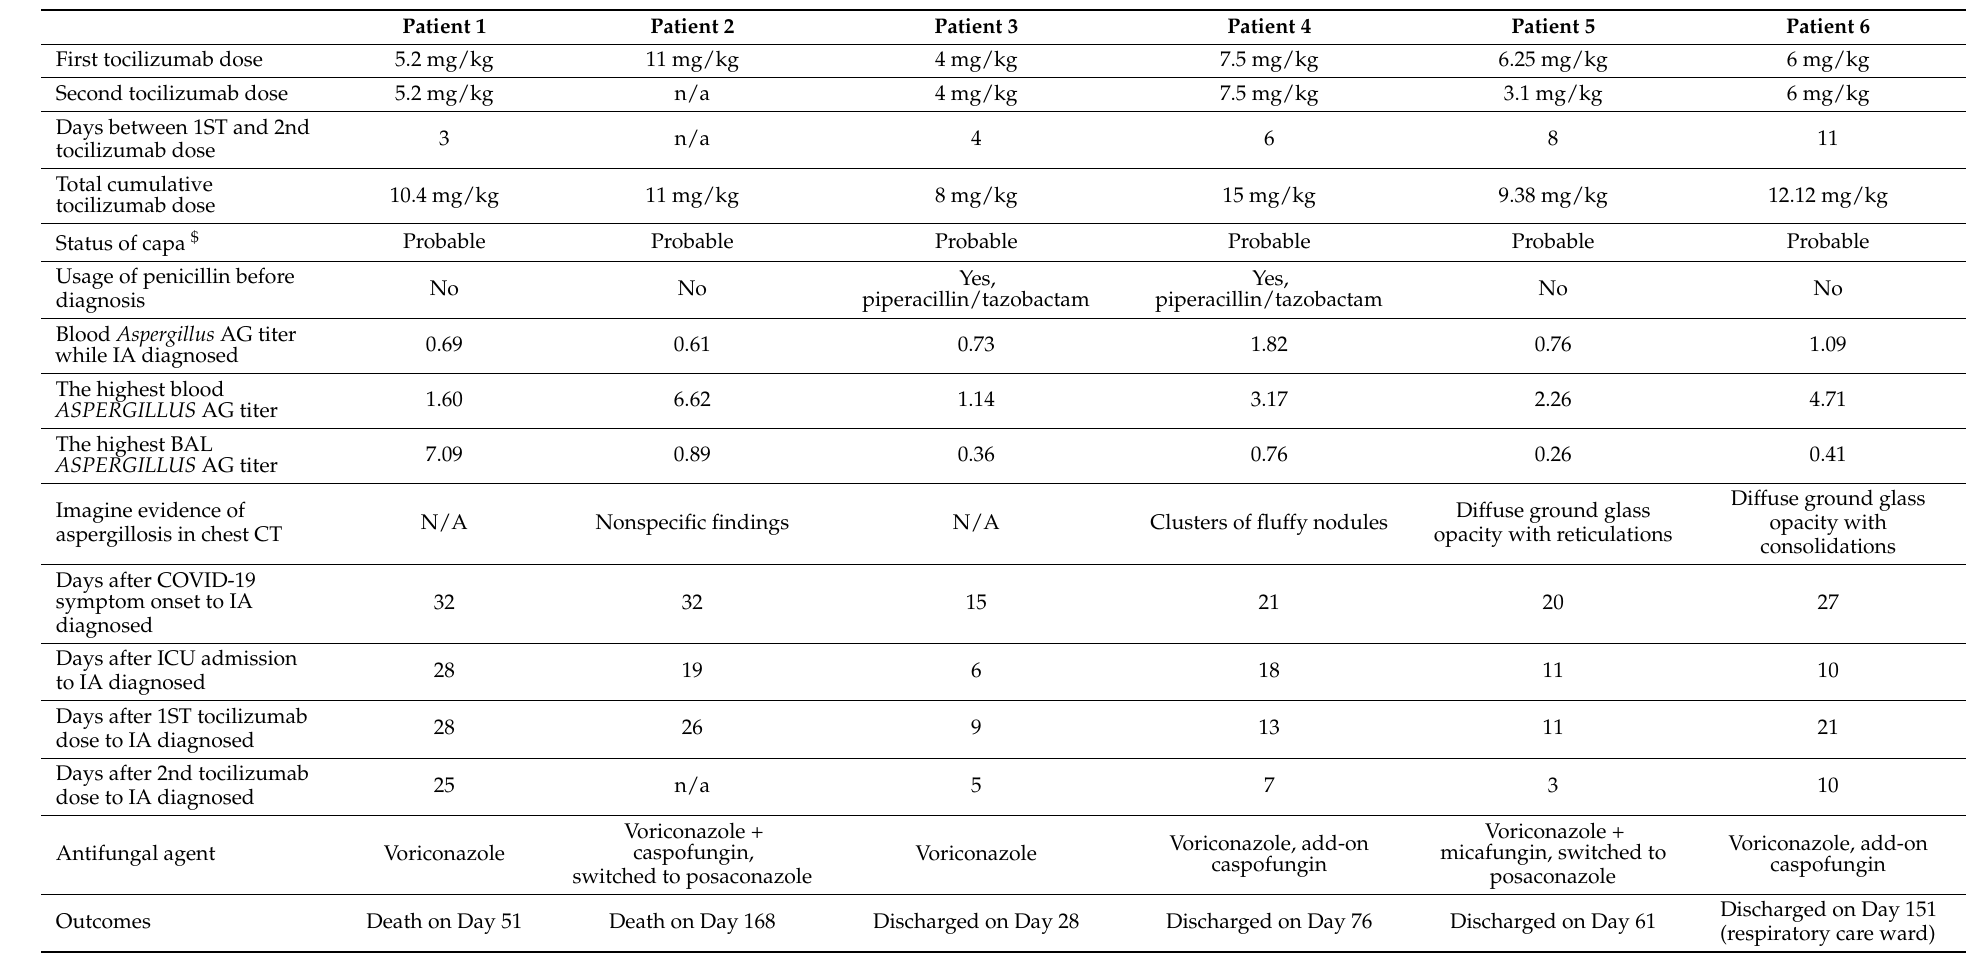
Table 2. Tocilizumab administration, diagnostic time, treatment of invasive aspergillosis, and outcomes. Patient 1 Patient 2 Patient 3 Patient 4 Patient 5 Patient